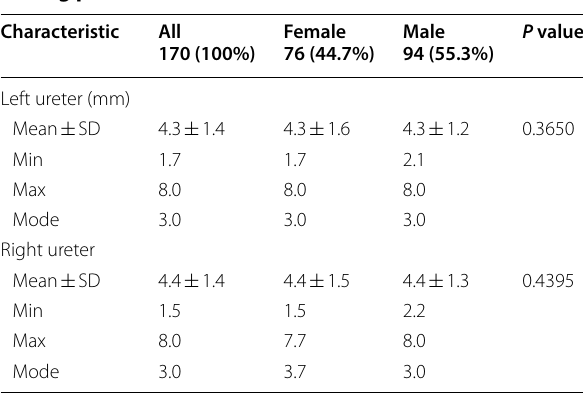
Table 2 Characteristics of ureteric diameter among patients